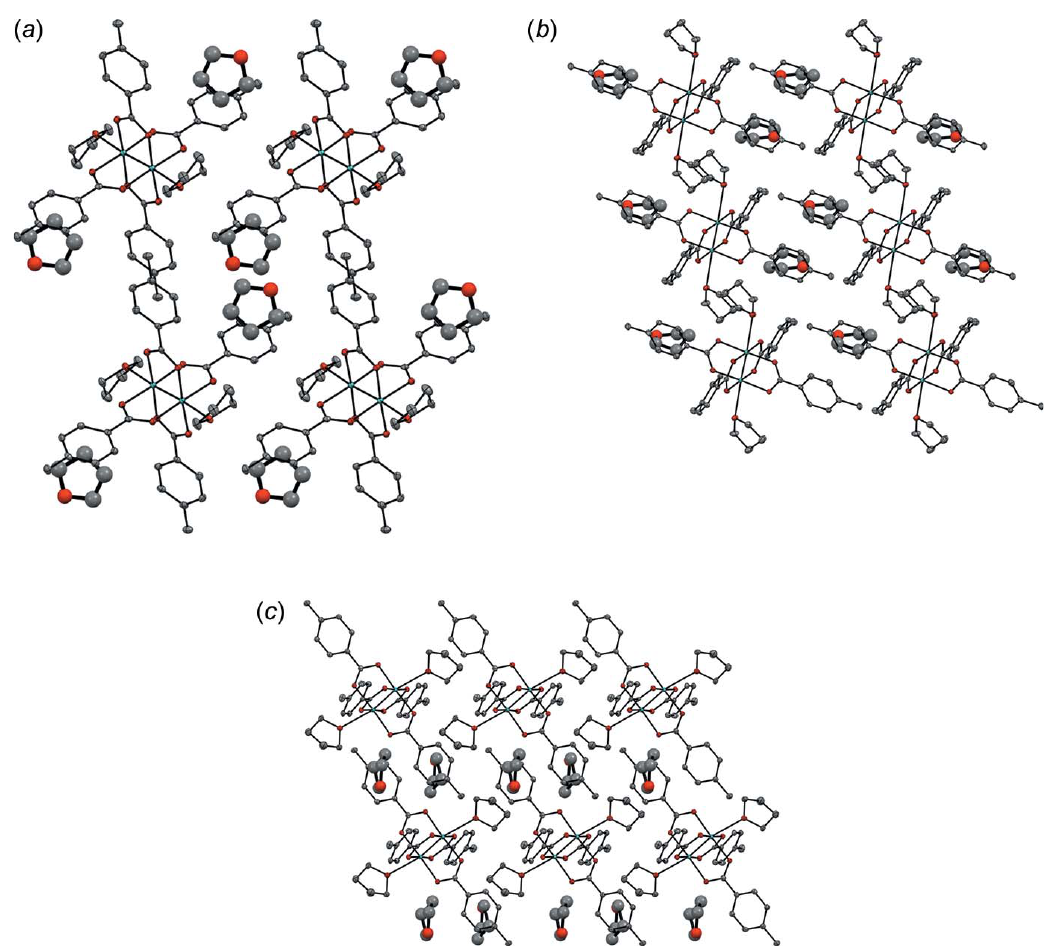
Figure 2 Crystal packing of the title compound shown along ( a ) the a -axis, ( b ) the b -axis, and ( c ) the c -axis. THF solvent molecules are present in the lattice. Color scheme: C (gray), O (red), Mo (teal). Hydrogen atoms are omitted for clarity.